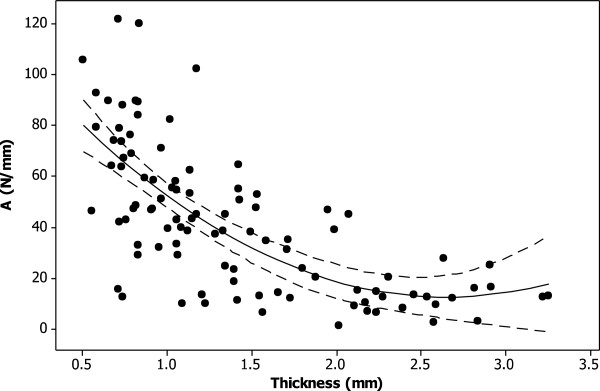
Thickness dependency of A (see equation 1) for knee joint cartilage. A second order polynomial curve (see equation 4) was fitted to the experimental data (R2 = 51%; p < 0.05) as shown (solid line). The 95% confidence intervals are also included (dashed line).